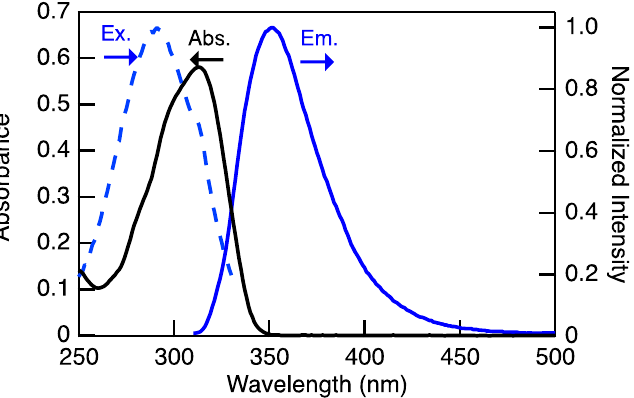
Figure 3. ( a ) Photophysical properties of B2-5 in a CH 2 Cl 2 solution: absorption, solid black line; emission, solid blue line; excitation, dashed blue line. [ B2-5 ] = 1 × 10 − 5 mol L − 1 for absorption spectra; [ B2-5 ] = 1.5 × 10 − 6 mol L − 1 for luminescence spectra. The excitation wavelength ( λ ex ) was 291 nm. Excitation spectra were monitored at 348 nm.